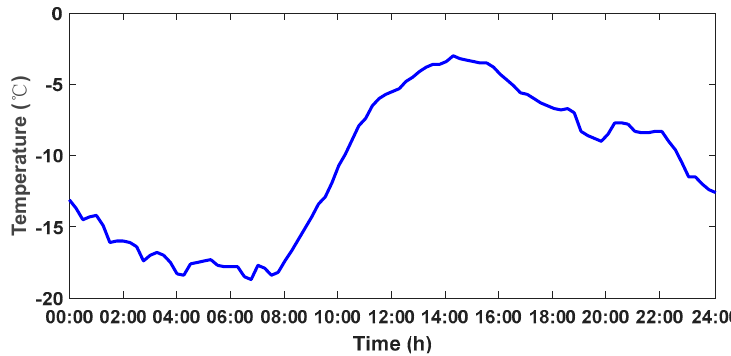
Figure 12. The outside humidity of the CSG on 26 January 2018.